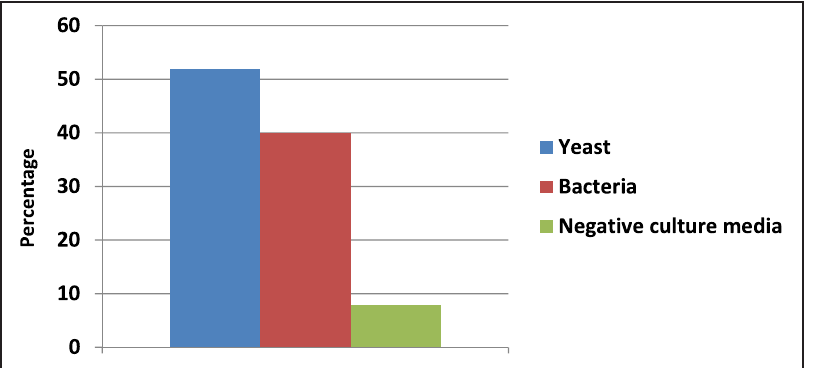
Fig. 1. Bar chart of percentage distribution for positive culture media (bacteria and